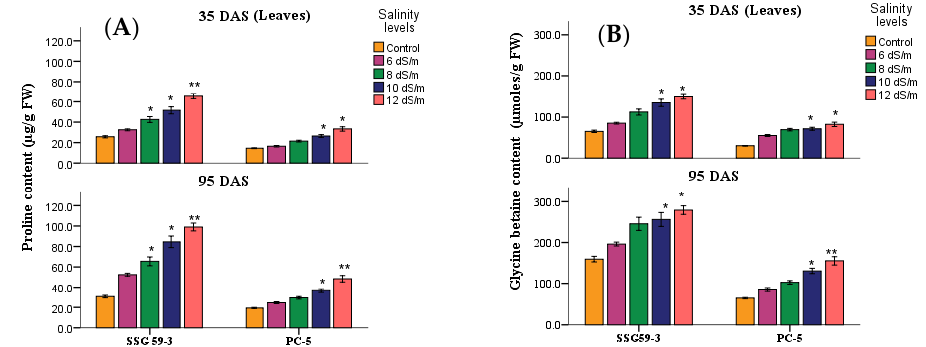
Figure 8. Effect of salt stress on proline (Pro, A ), and glycine betaine (GB, B ) of sorghum genotypes at 35 and 95 DAS. All values are the means ± SD of three biological replicates. Asterisks represent significant (*) and highly significant (**) differences among different treatments.